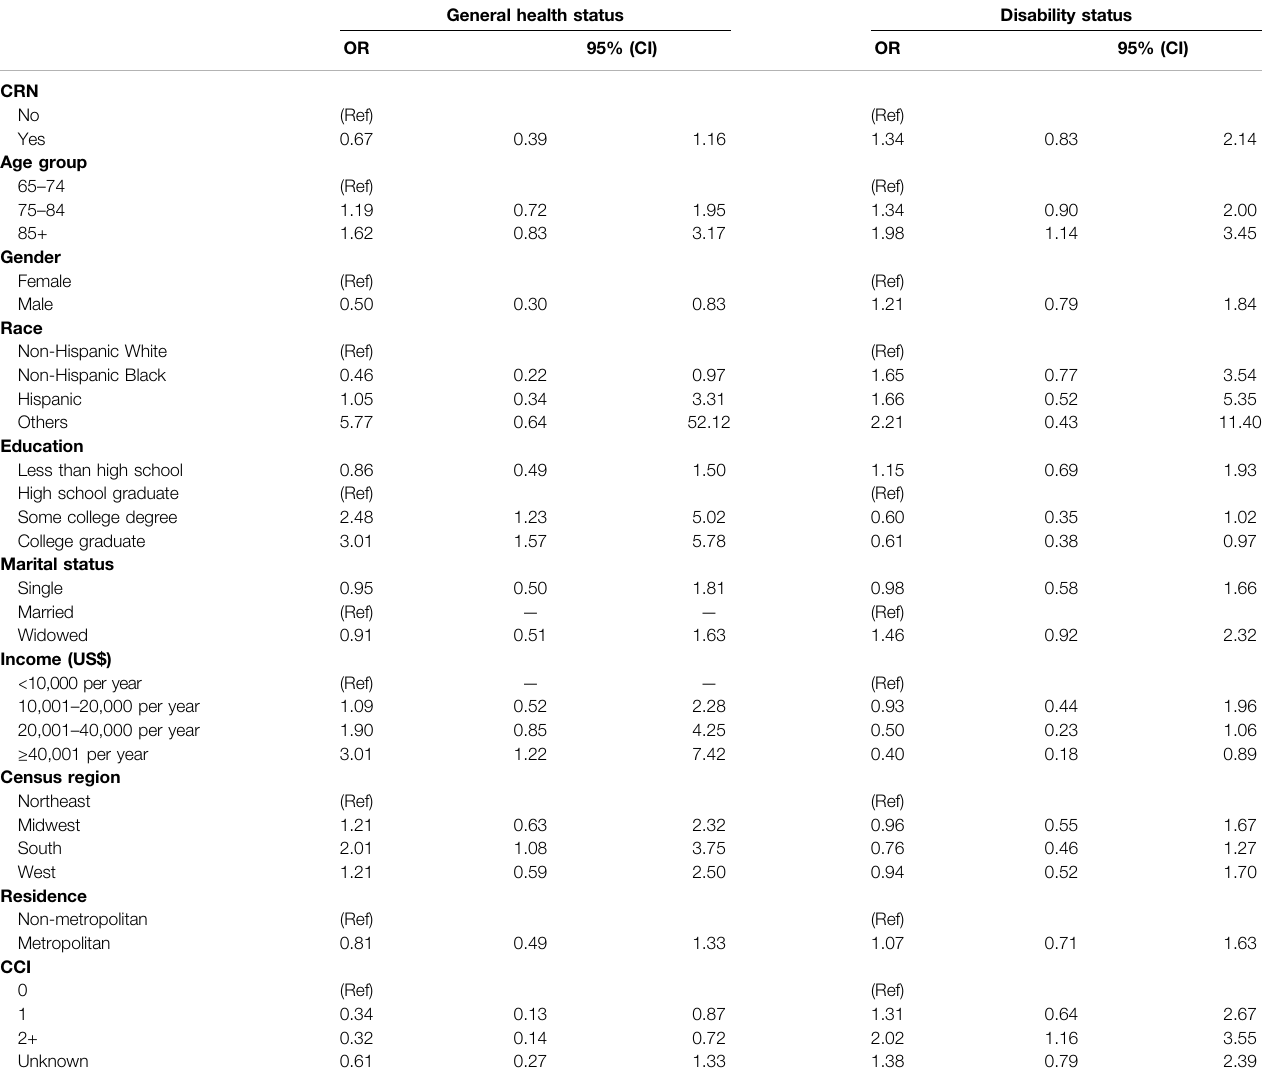
TABLE 2 | The association of CRN on patients ’ reported health